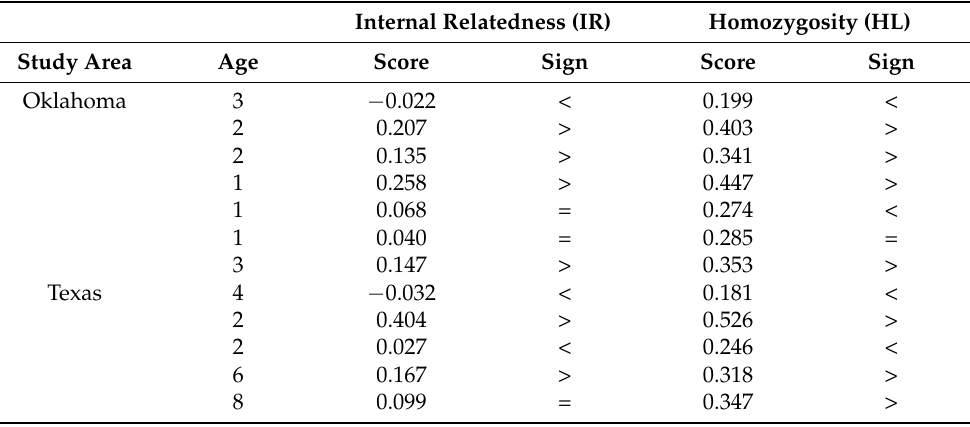
Table 3. Individual internal relatedness (IR) and homozygosity weighted by locus (HL) scores of white-tailed deer ( Odocoileus virginianus ) with antler malformations from Oklahoma (1991–2005) and Texas (1999–2005). Sign indicates whether individual deer score was below (<), above (>) or within (=) the 95% CI calculated for deer with normal antlers from its corresponding population (cf. Table